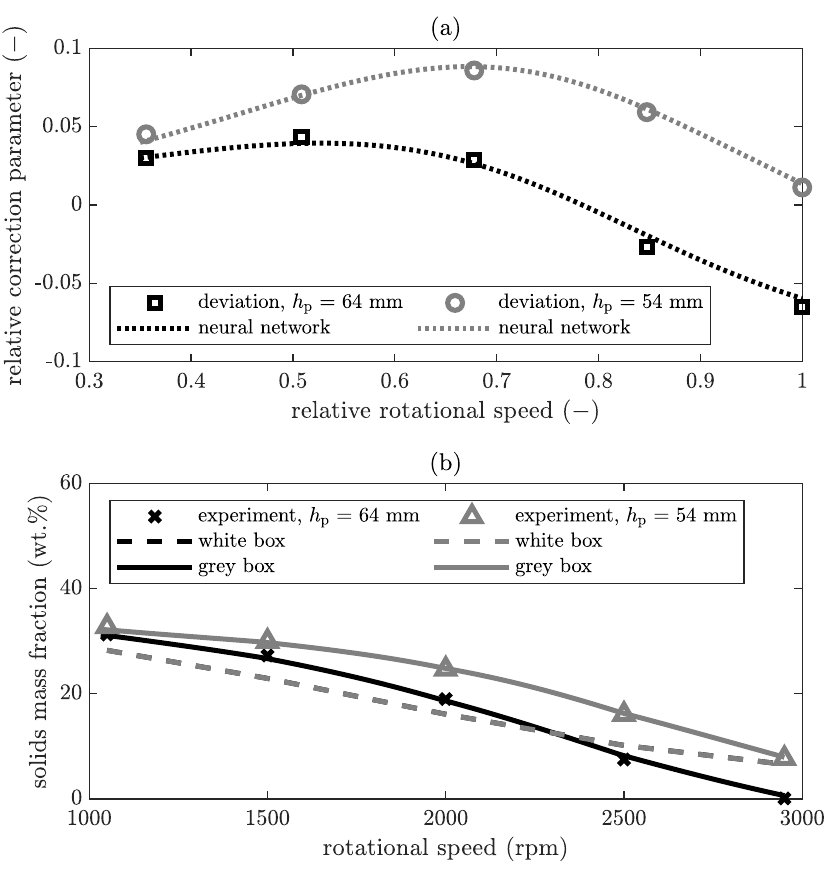
Figure 8. Solids mass fraction of the centrate at a constant volumetric flow rate of ˙ V in = 2000Lh − 1 for the product CC1: ( a ) relativised output of the black box model, ( b ) comparison of the results from experiment, white, and grey box